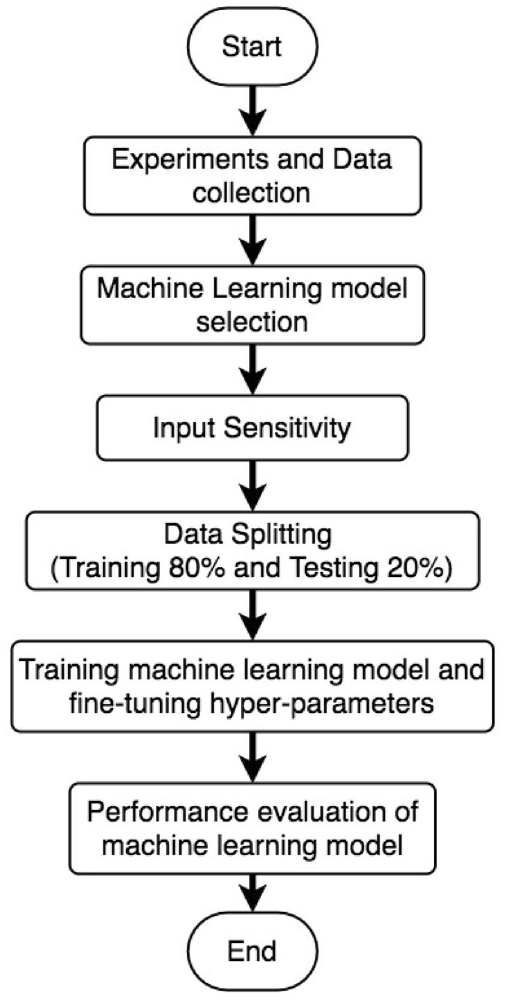
Figure 9. Flow chart of the proposed methodology to forecast sediment using machine learning